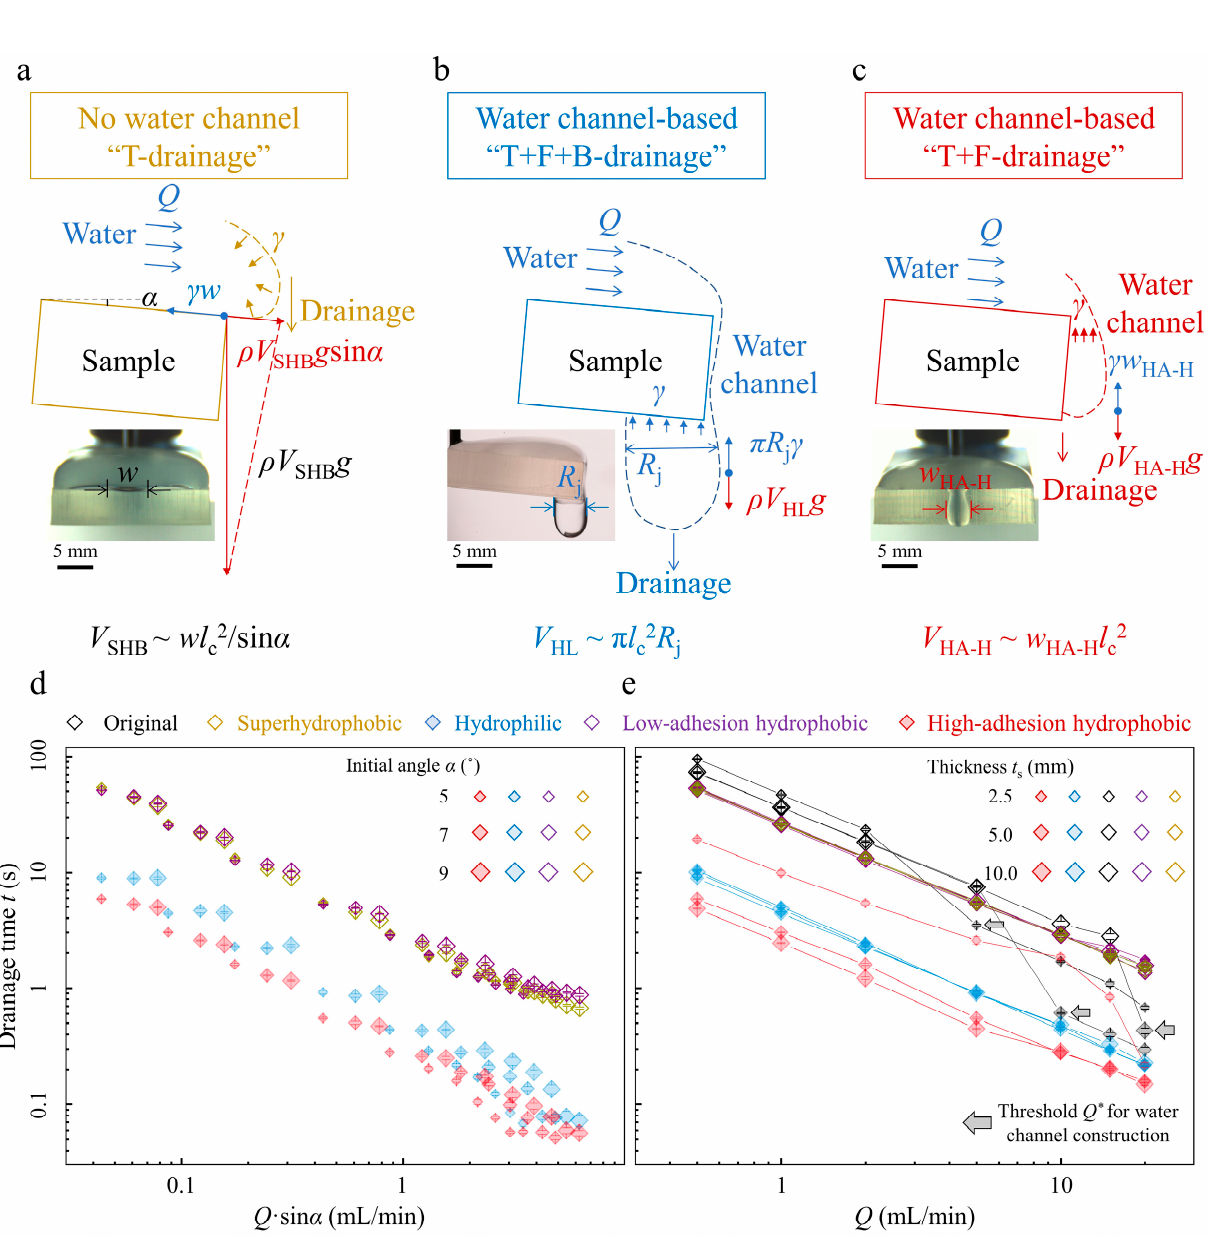
Figure 3. Drainage mechanisms and experimental parameters regulating different drainage modes. ( a – c ) Schematic diagrams and corresponding critical snapshots (inset) for different drainage modes. The driving force of gravity overcomes the resisting capillary resistance, and one droplet drainage happens. ( d ) Drainage time t versus water flow rate Q modified by the initial angle α for different margin modifications. ( e ) Drainage time t versus water flow rate Q under different margin thicknesses for various margin modifications. The arrows indicate the threshold water flow rates for the original margin samples. The error bar represents the standard deviations for at least five independent measurements.